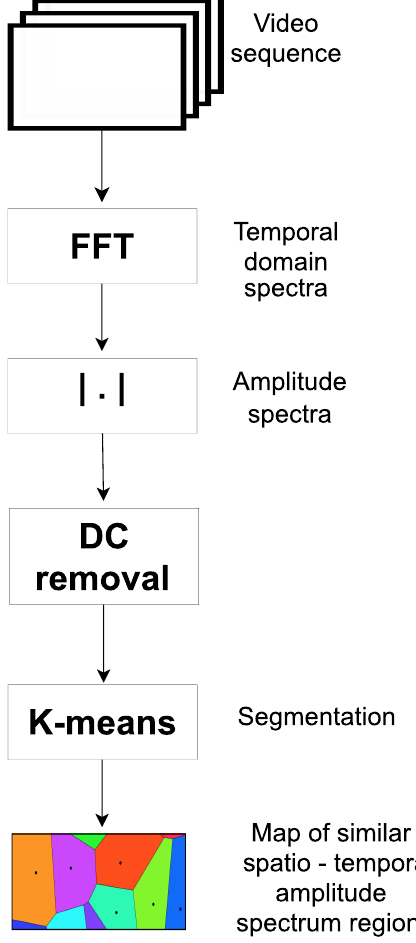
Figure 11. Diagram of